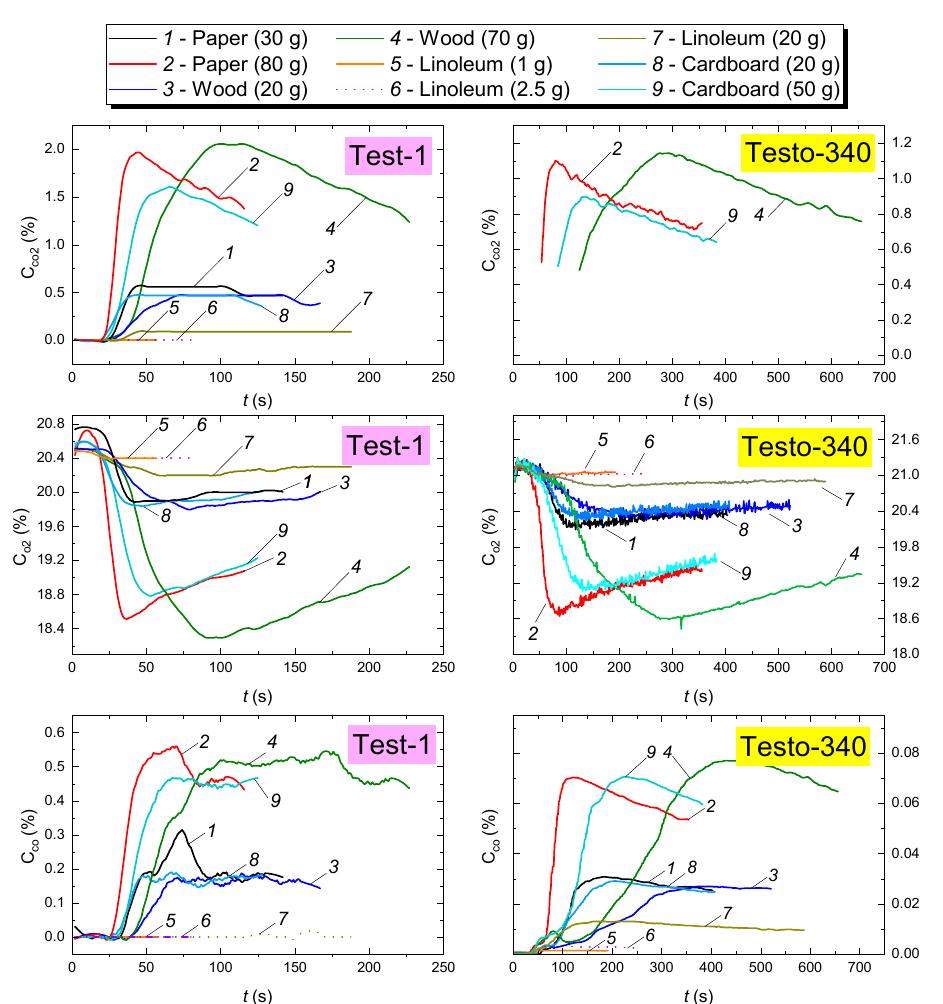
Figure 7. CO, CO 2 and O 2 concentrations in the SC during combustion and smoldering of model fires versus time.